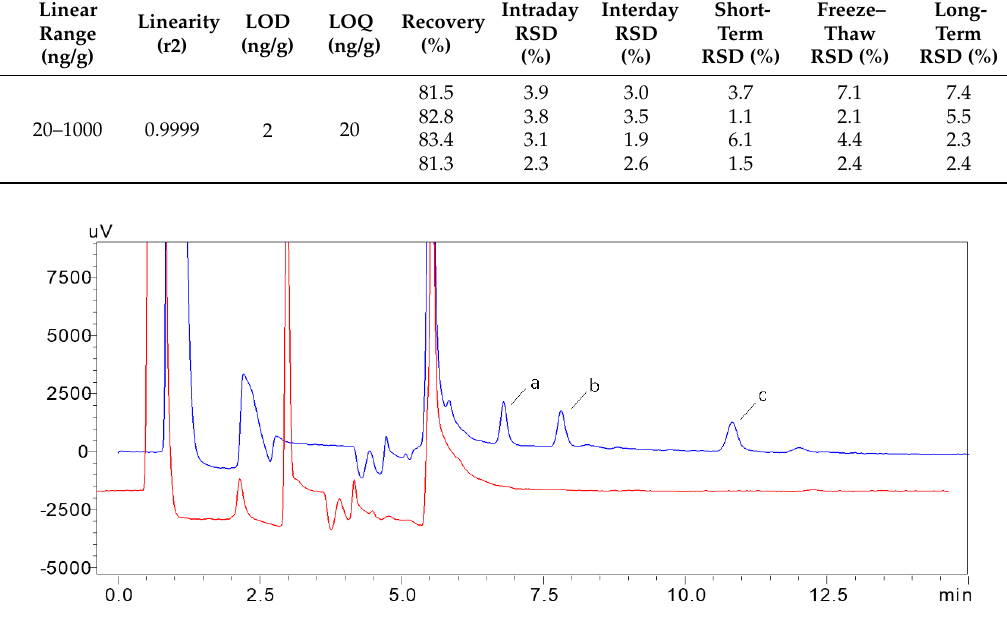
Figure 4. 2D ‐ LC of blank samples (red) and added sample (bule ‐ 20 ng/g) ( a ) gelsemine, ( b ) koumine Figure 4. 2D-LC of blank samples (red) and added sample (bule-20 ng/g) ( a ) gelsemine, ( b ) koumine and ( c ) humantenmine. and ( c ) humantenmine. Table 3. Results of standard stock solution Table 2. Results of linear range, correlation coefficient, LOD, recovery, accuracy, precision and sam ‐ ple stability.